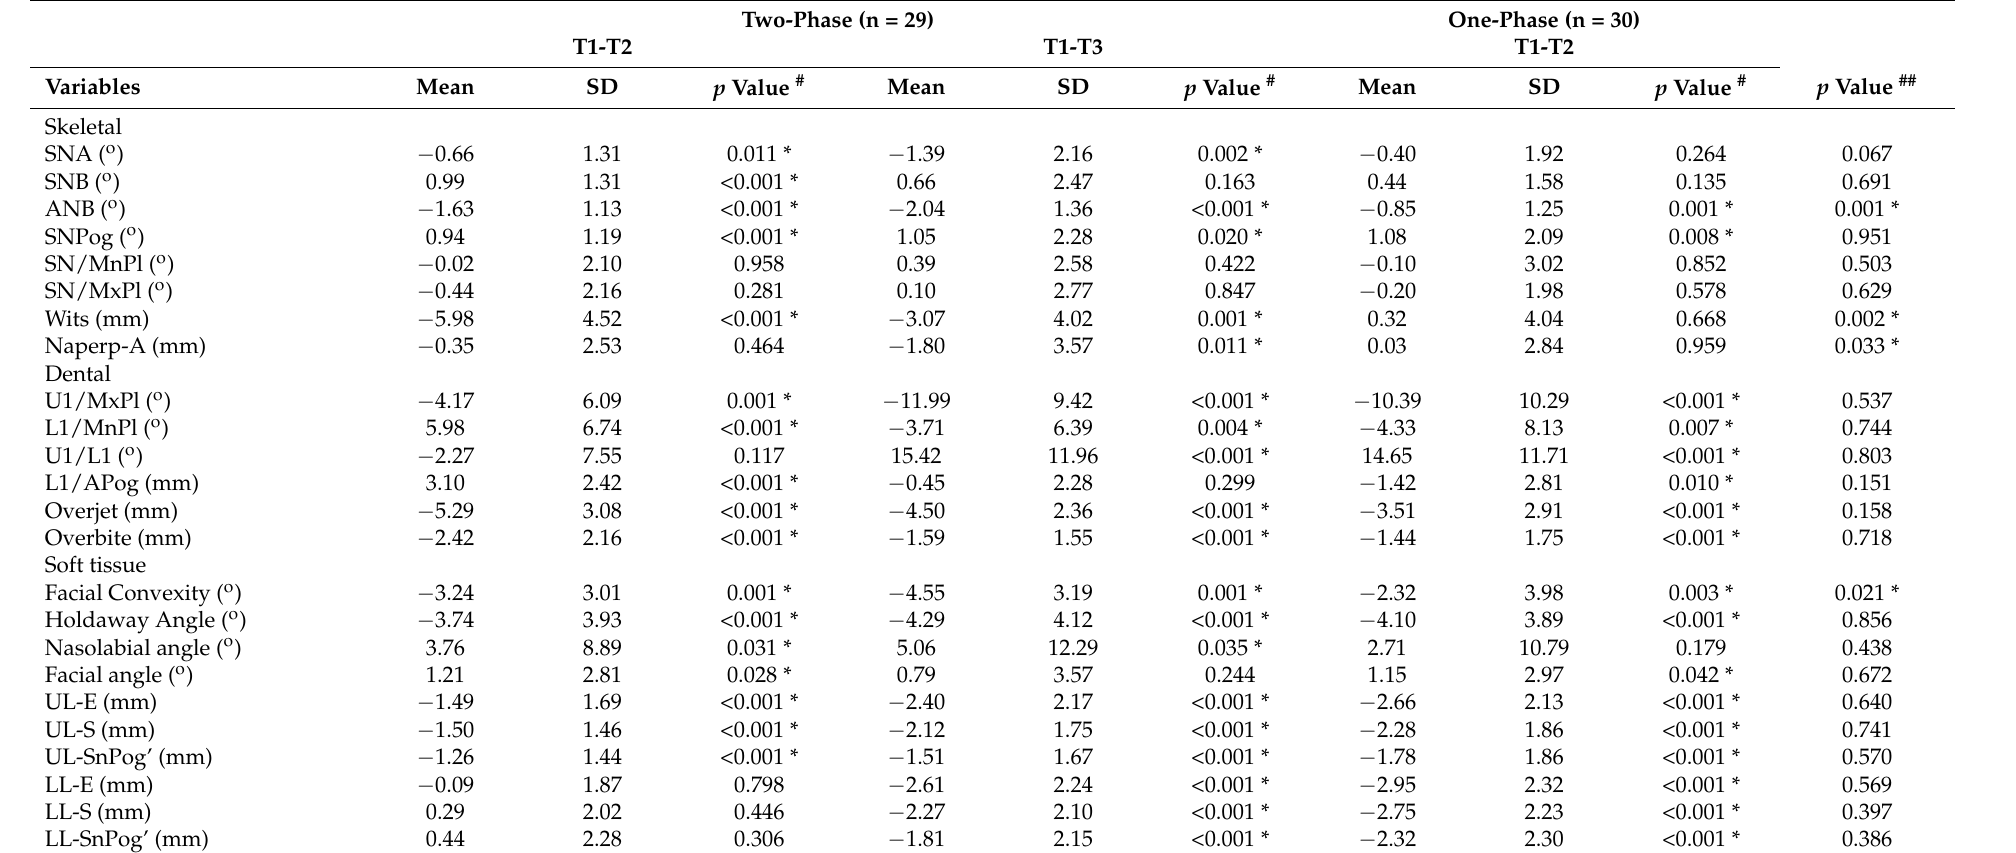
Table 4. Intragroup and intergroup comparison of treatment